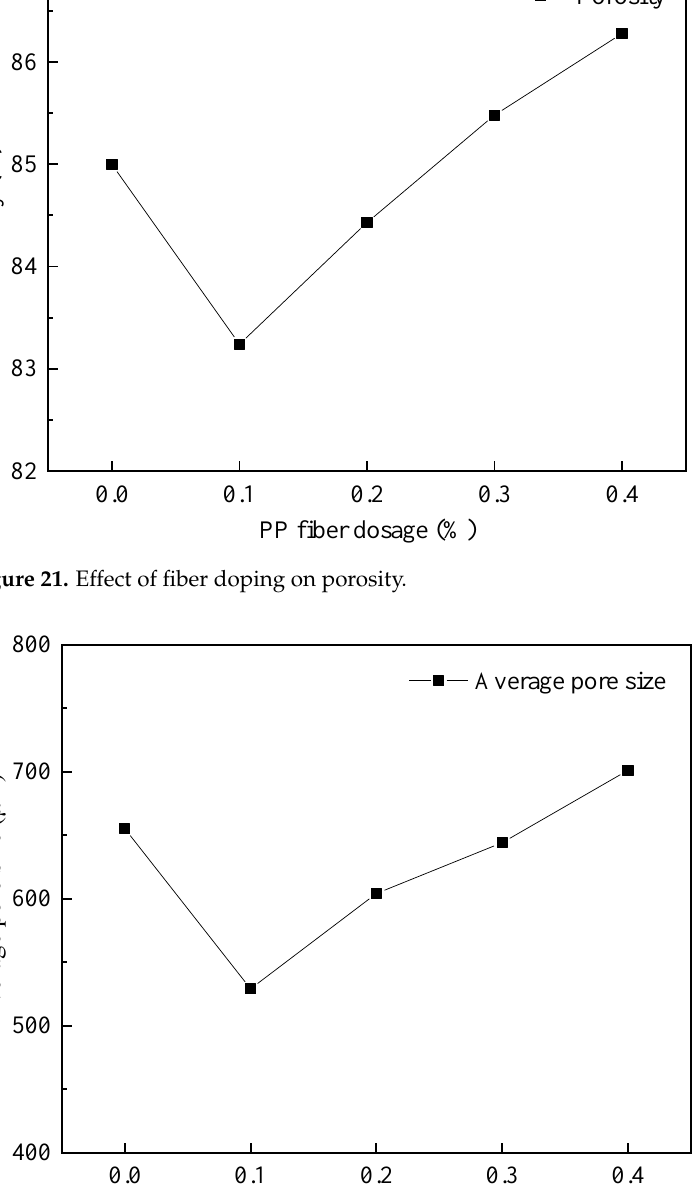
Figure 22. Effect of fiber doping on the average pore size.